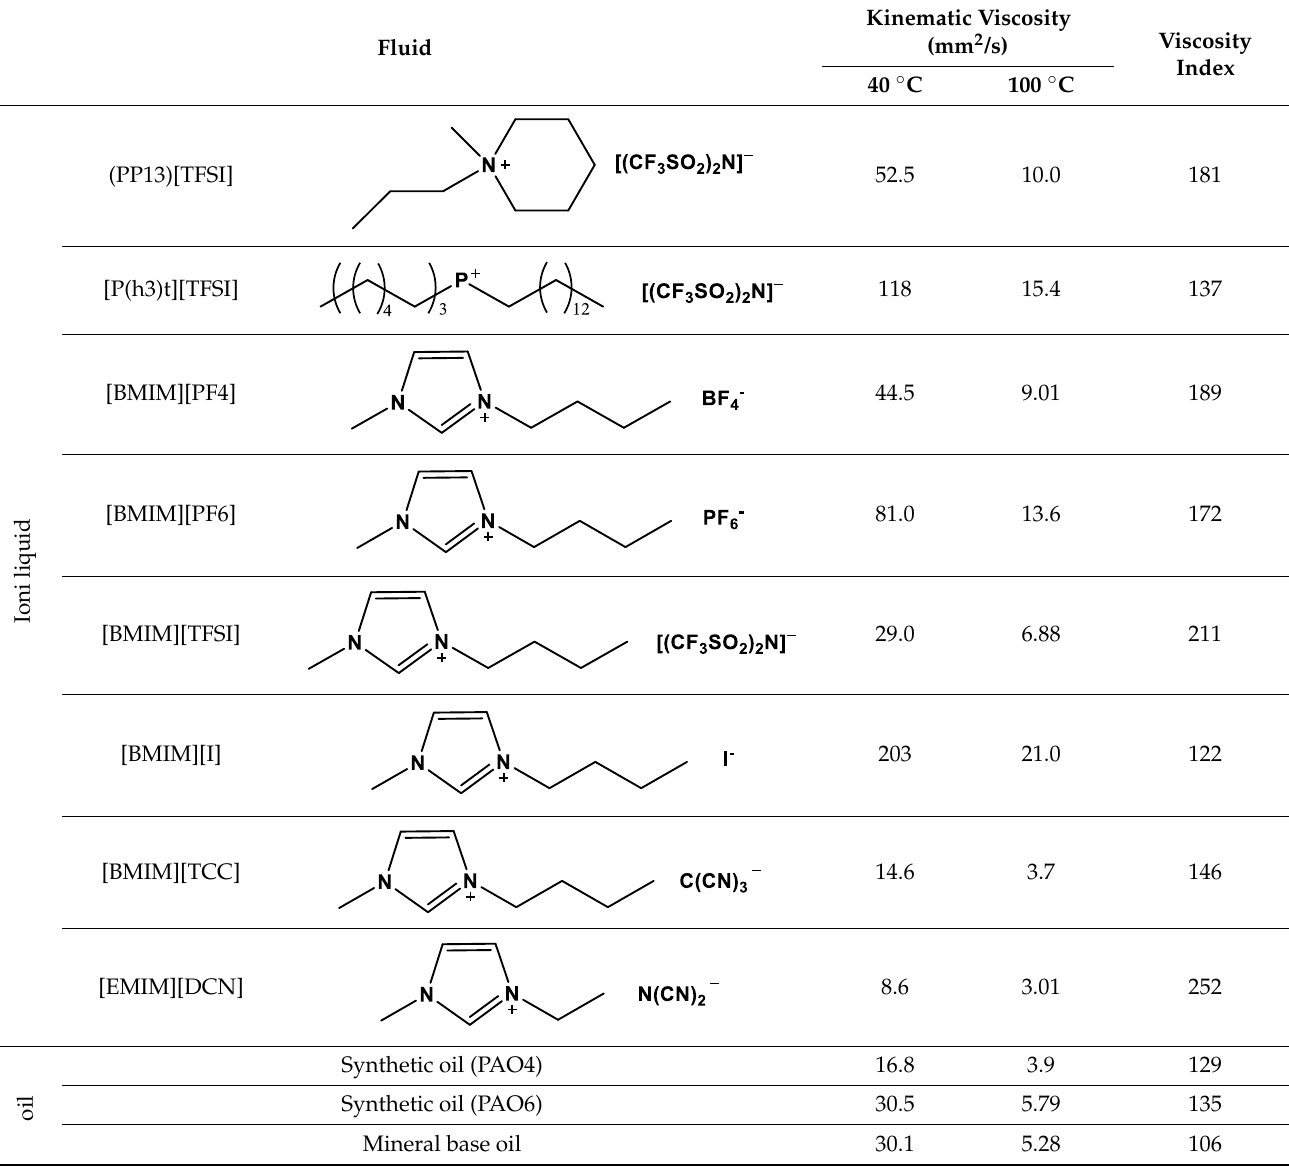
Table 2. Viscosity index of some ionic liquids and base oils at different temperatures.